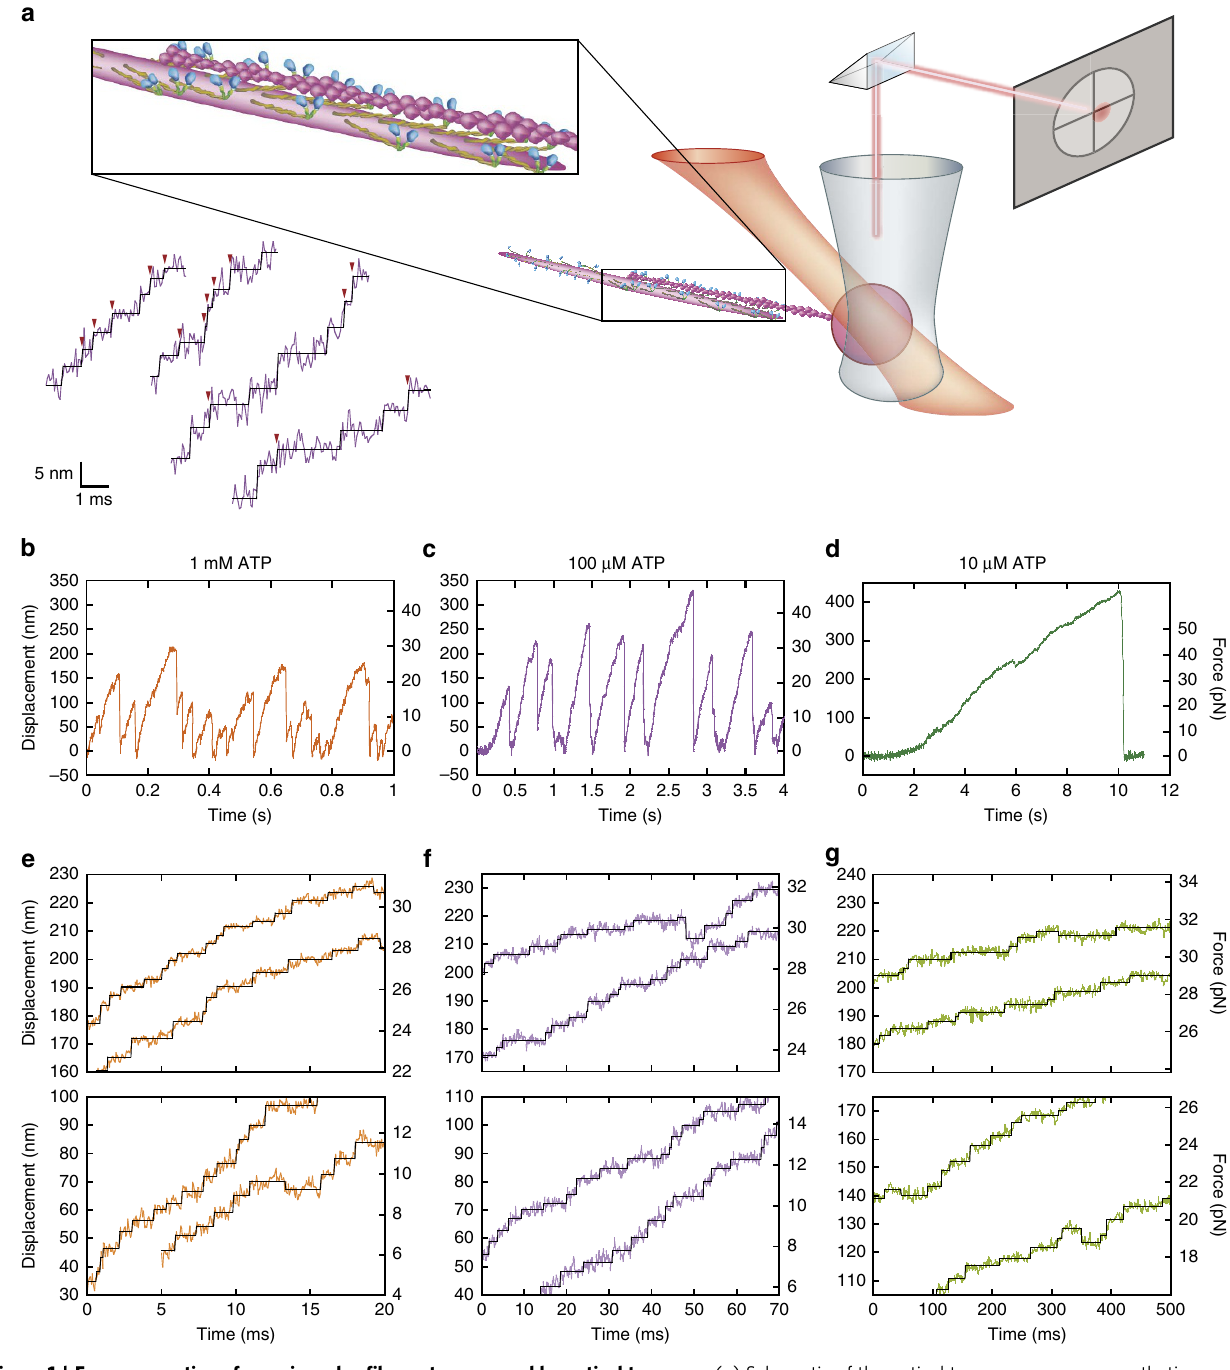
Figure 1 | Force generation of myosin-rod cofilaments measured by optical tweezers. ( a ) Schematic of the optical tweezer assay on a synthetic myosin- rod cofilament interacting with an actin filament. A bead coated with streptavidin is attached to a biotinylated actin filament and held above a myosin-rod cofilament. Scattered images of beads diagonally illuminated by a red laser are projected onto a quadrant photodiode sensor. Inset: measured bead displacements with detected steps (black) reveal stepwise displacements that are frequently generated within 1ms (red arrowheads). ( b – d ) Time courses of bead displacement at 1mM, 100 m M and 10 m M ATP in b – d , respectively. ( e – g ) Stepwise displacements of actin filaments in response to low loads (bottom panels) and high loads (top panels) at 1mM, 100 m M and 10 m M ATP in e – g , respectively. The black solid lines represent steps detected by the step-finding algorithm 40